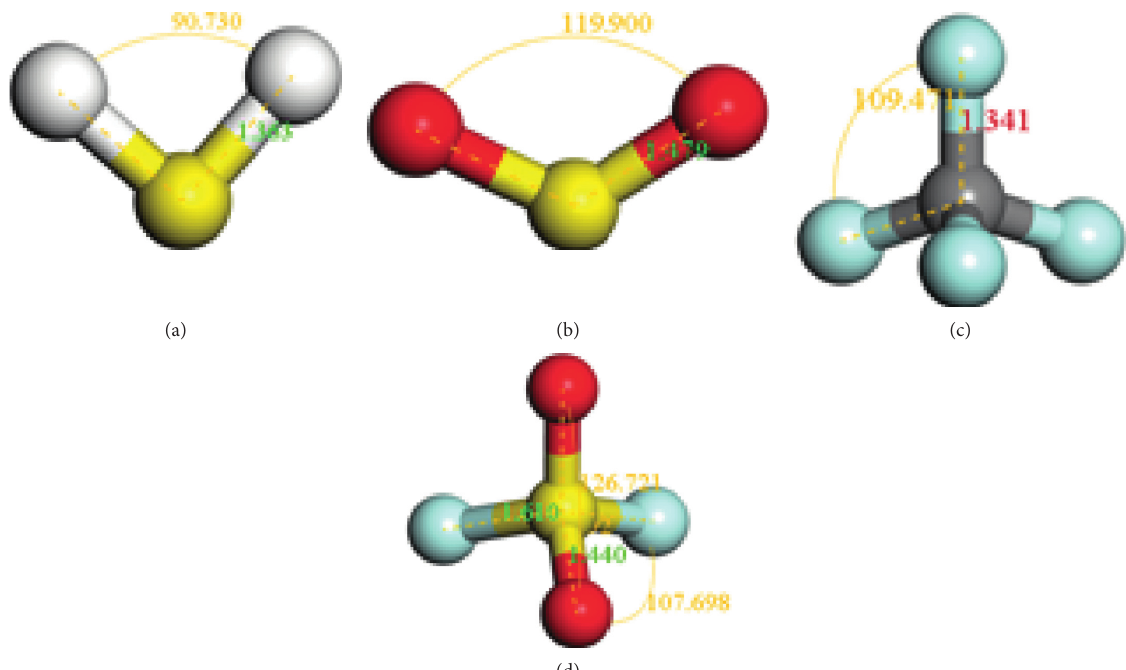
Figure 4: Optimized gas model: (a) H